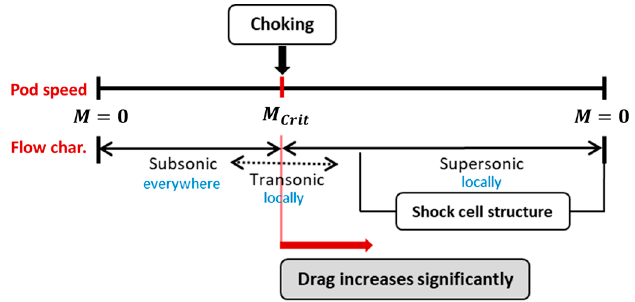
Figure 4. Effects of pod speed on the flow characteristics near the pod. Drag increases significantly when the pod speed is greater than the critical Mach number due to choked flow.